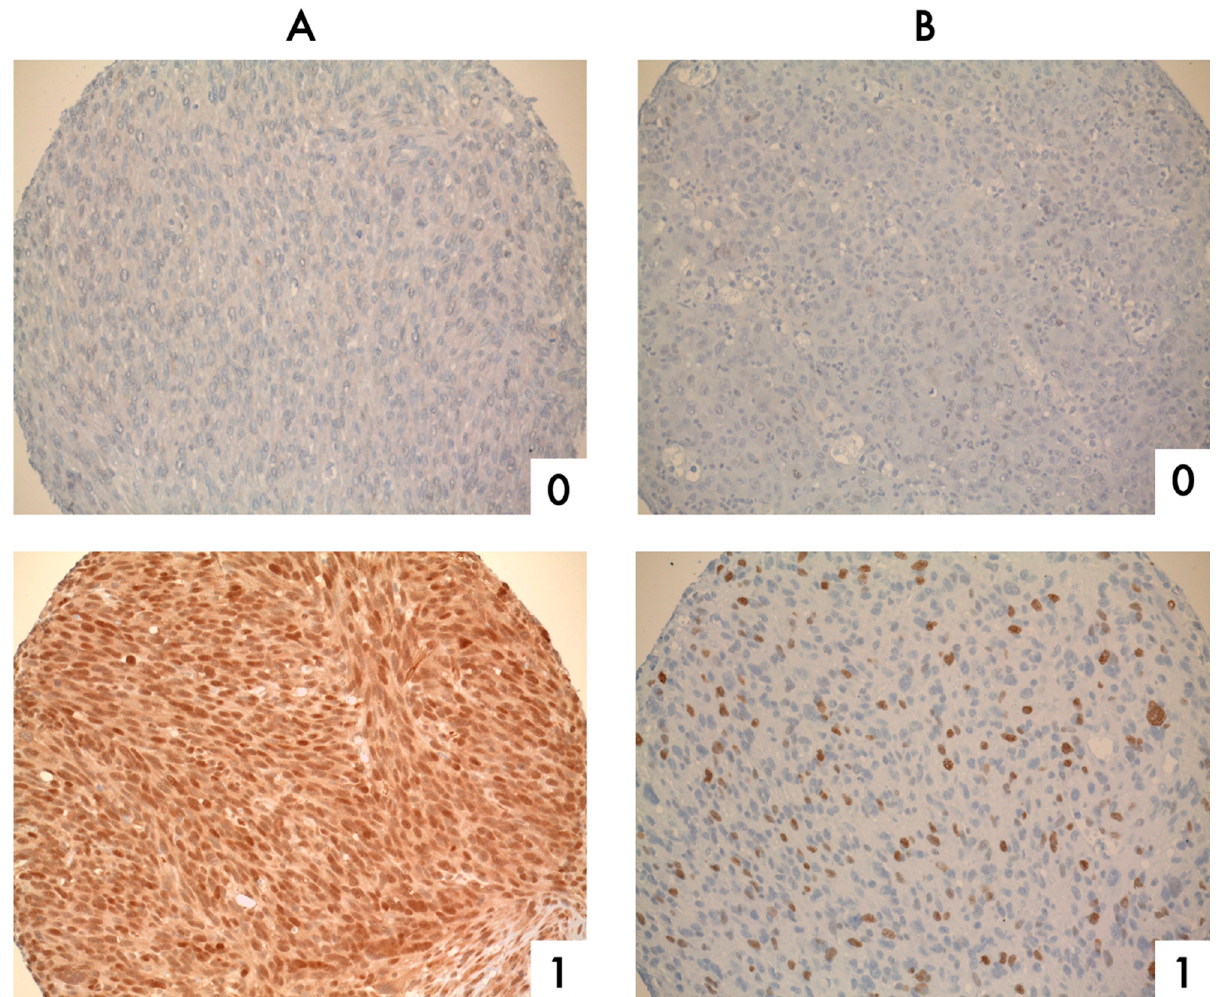
Figure 1. Stained tissue microarray cores. Representative micrographs of cores on a tissue microarray stained for ( A ) SIRT1 and ( B ) TOP2A. Numbers represent semiquantitative scoring of immunostaining: 0, negative; 1, positive. Magnification 20×.